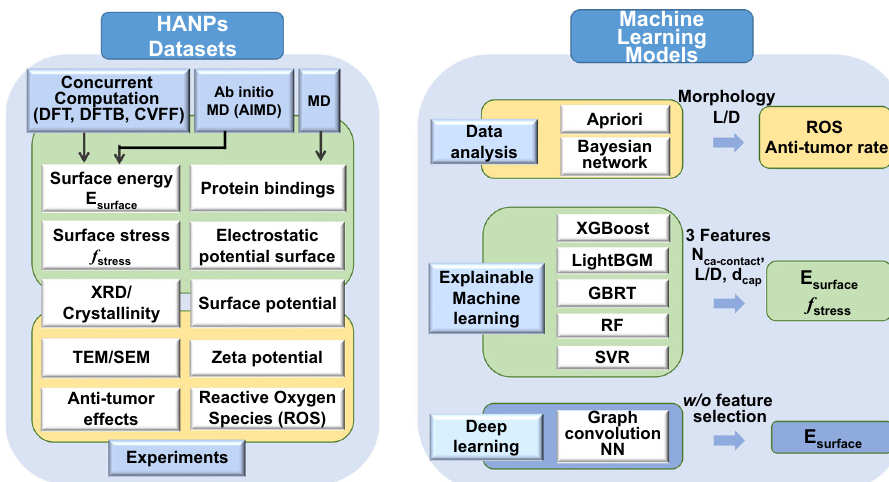
Fig. 1 HANPs datasets constructed from experiments and calculations for machine learning of